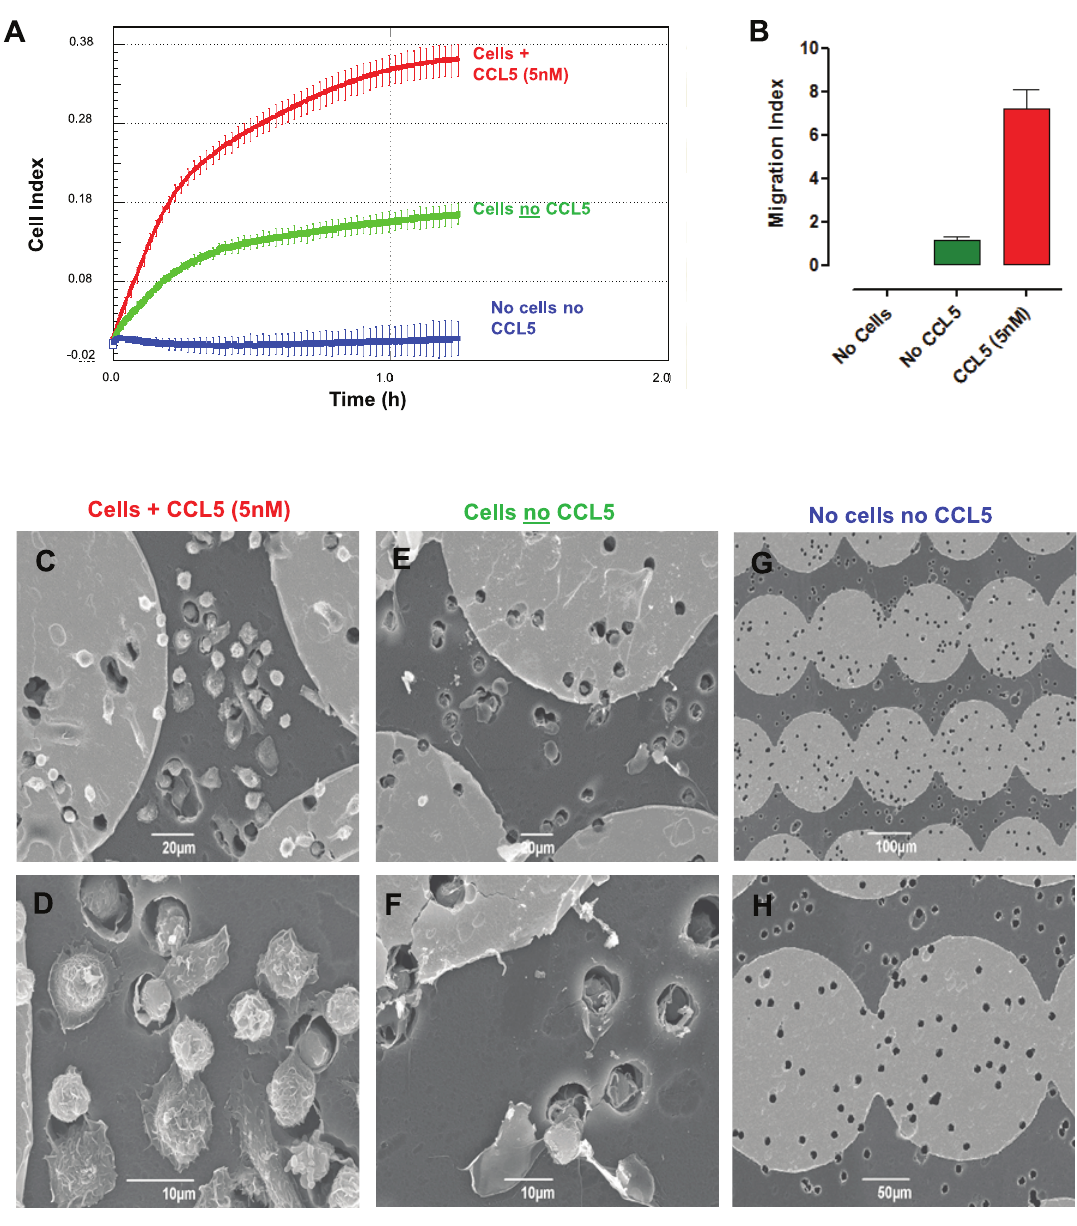
Figure 1. Real-time chemotaxis of Bio-Gel elicited macrophages to murine CCL5. ( A ) ( A ) Representative trace from the RTCA-DP software of 4 6 10 5 Bio-Gel elicited macrophages from C57BL/6J male mice in the top chamber with murine CCL5 (5 nM) (red) or no chemokine (green) in the bottom chamber. A control of no macrophages and no chemokine was also run (blue). By 70 mins max CI had been reached, the plate was removed and membranes were cut and fixed with 2.5% gluteraldehyde and processed for scanning electron microscopy (SEM). Representative images are shown of macrophages adhered to the underside of filters in response to 5 nM murine CCL5 ( C & D ) no chemokine ( E & F ) or control where no cells or chemokine were added ( G & H ). Pores in the membrane are clearly visible in panel H . The number of cells adhered to individual gold discs on the underside of the membrane (seen as light grey regions in the SEM images) were quantitated (n=1 experiment with technical replicates of each condition analysed) ( B